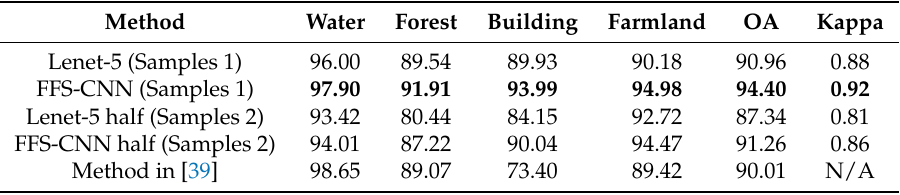
Table 2. The classification accuracies of RS-2 Flevoland (%).